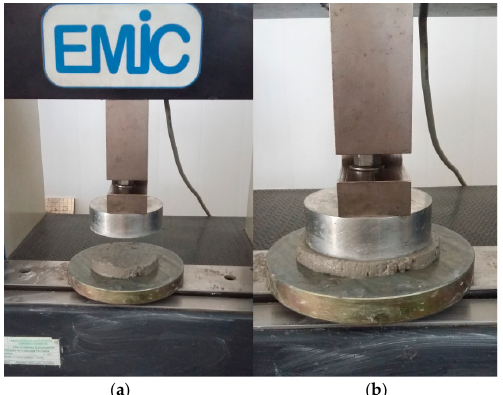
Figure 1. Exemplification of the rheology test by squeeze–flow. ( a ) Molded Sample and ( b ) compression in